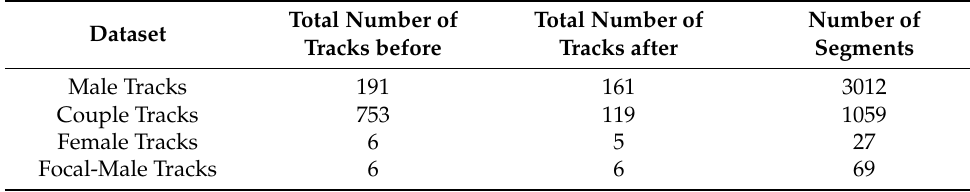
Table 2. Number of tracks and segments following initial processing.